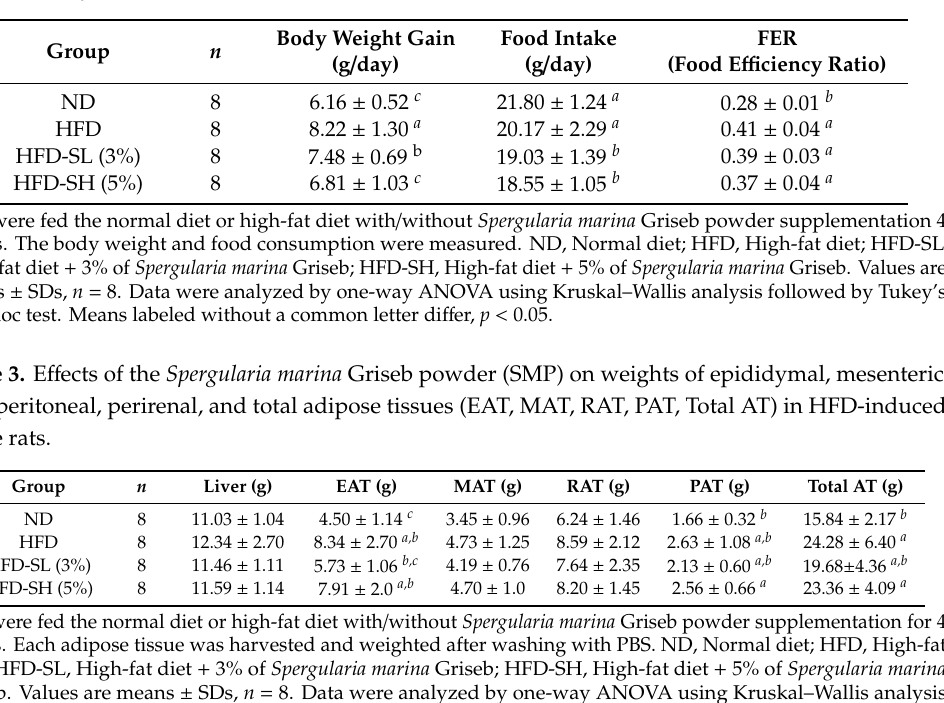
Table 2. E ff ects of the Spergularia marina Griseb powder (SMP) on body weight gain, food intake and food e ffi ciency ratio in HFD-induced obese rats.